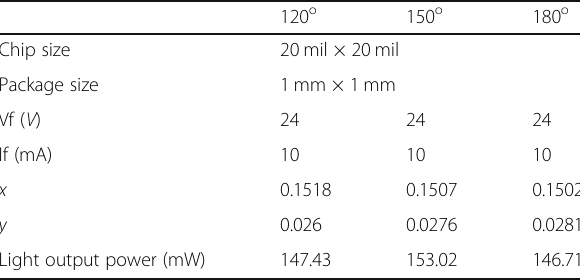
Table 1 Optoelectronic properties of the three kinds of